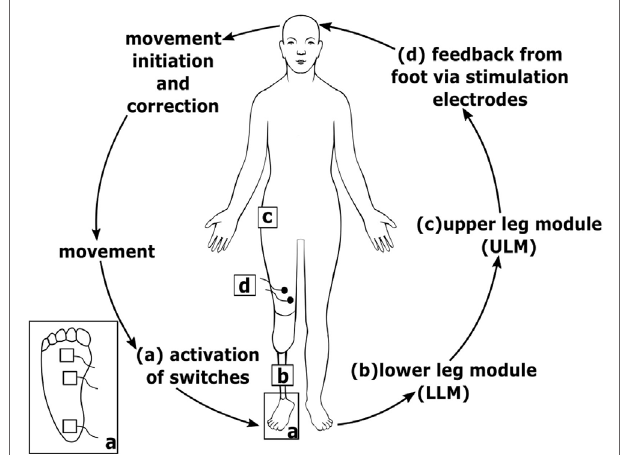
FigUre 2 | Scheme of the technical system. (a) Sensors at the prosthesis foot detect ground contact and send signal to lower leg module (LLM) (b); LLM (b) sends information to upper leg module (ULM) (c) via Bluetooth connection; ULM (c) generates electrocutaneous stimulation signals that are applied via stimulation electrodes (d) at the thigh; inset (a) bottom view of the prosthesis foot with three